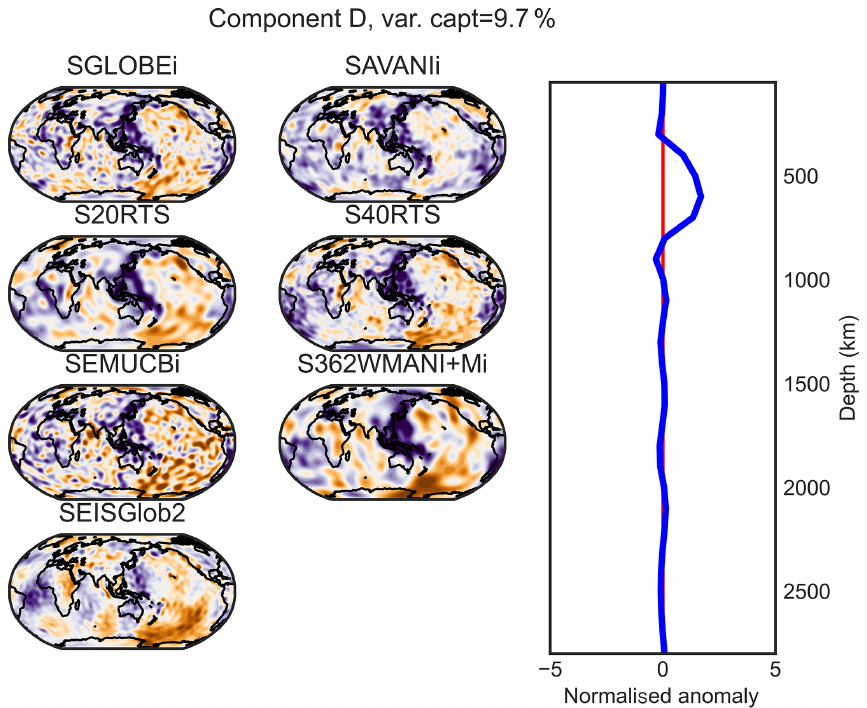
Figure D4. PC D (maximum at 600km of depth) of the combined analysis of the isotropic parts of the models.